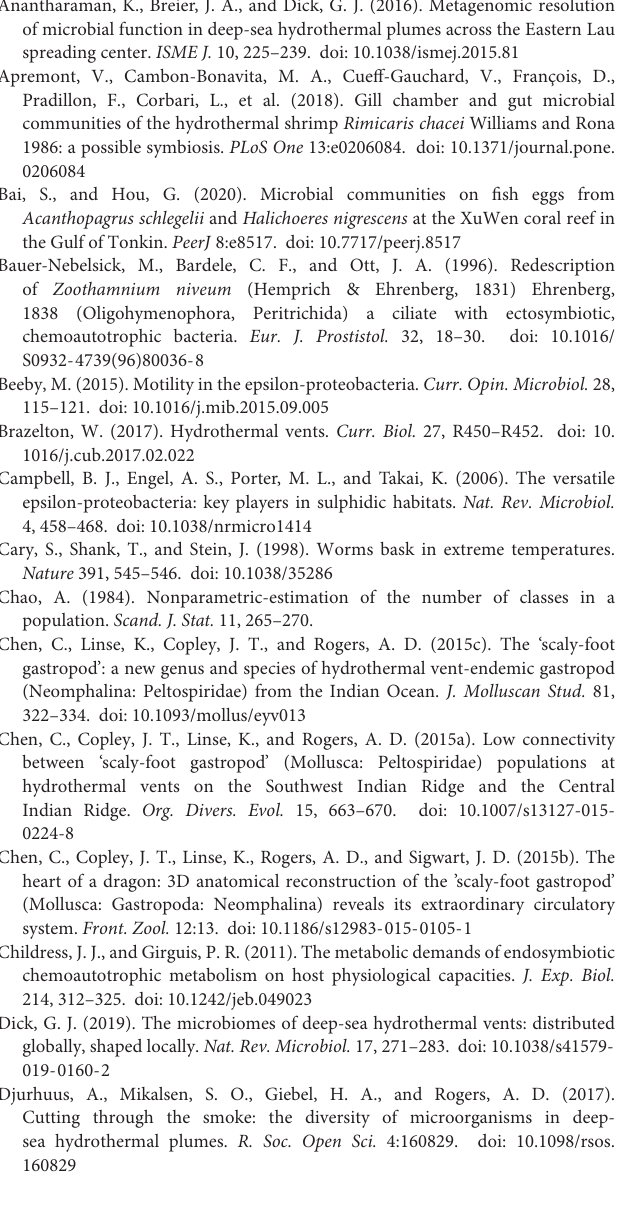
microbial abundance was scaled with log transformation in the heatmap. Kr refers to SFS samples collected from the Kairei vent field; Lq refers to SFS samples collected from the Longqi vent field. Supplementary Figure 6 | The importance (A) and the heatmap (B) of the 20 most important OTUs, which distinguished the samples of Kr16 and Lq. The microbial abundance was scaled with log transformation in the heatmap. Kr16 refers to SFS samples collected from the Kairei vent field, and reared for 16 days; Lq refers to SFS samples collected from the Longqi vent field. Supplementary Figure 7 | The importance (A) and the heatmap (B) of the 20 most important OTUs, which distinguished the samples of Kr and Kr16. The microbial abundance was scaled with log transformation in the heatmap. Kr refers to SFS samples collected from the Kairei vent field; Kr16 refers to SFS samples collected from the Kairei vent field, and reared for 16